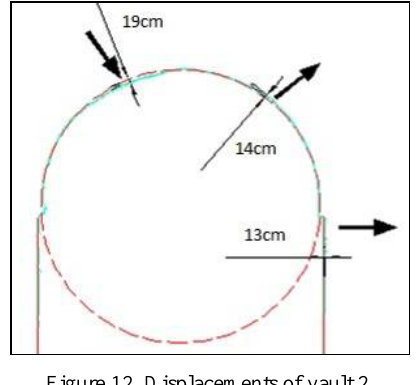
Figure 12. Displacements of vault 2.